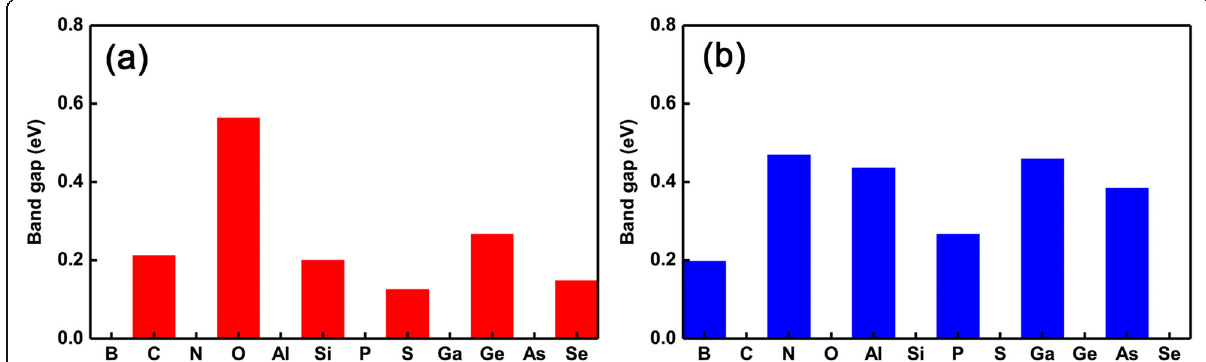
Fig. 4 Band gaps of all single-doped systems. Band gaps of doped GeP 3 monolayers with the different dopants ranging from group V to VI. a the substitution of Ge atoms and b the substitution P atoms,